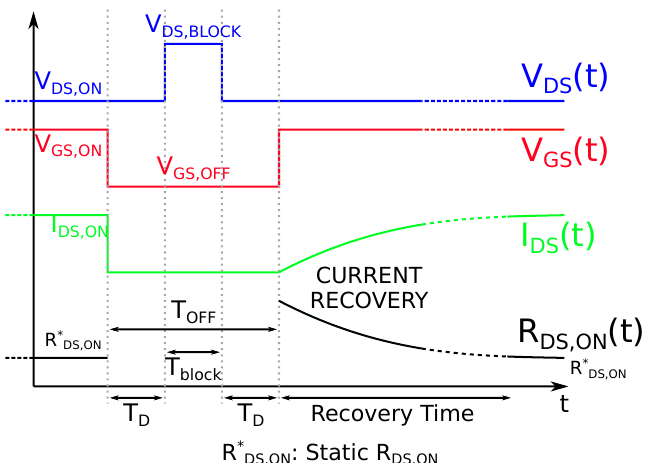
Figure 1. Typical waveforms of V GS , V DS , and I DS during the dynamic characterization in periodic regime: waveforms of one period.